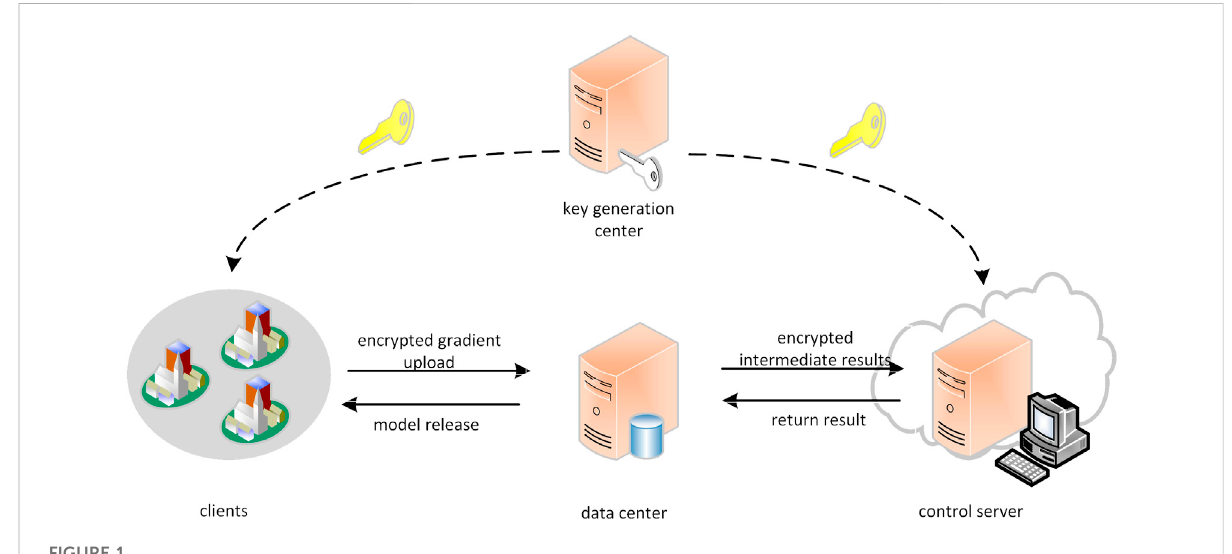
FIGURE 1 Smart grid AMI system model.